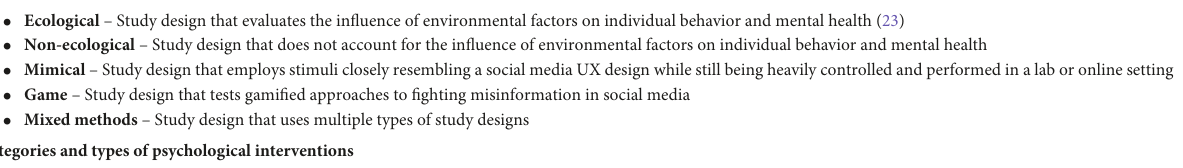
TABLE 1 Glossary of key terms used in current study, (see Figure 2